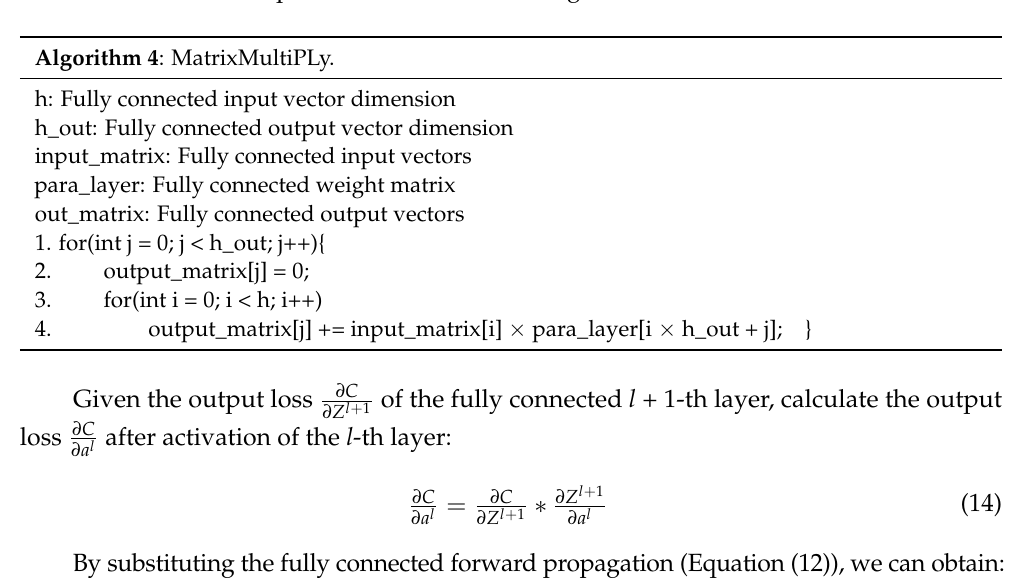
Figure 8. Data propagation at the full connection layer.